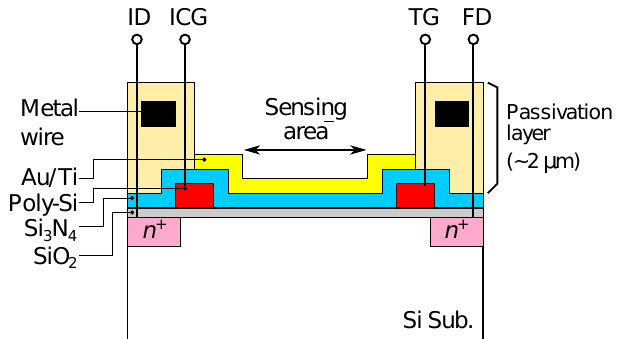
Figure 1. Schematic illustration of pixel structure of fabricated